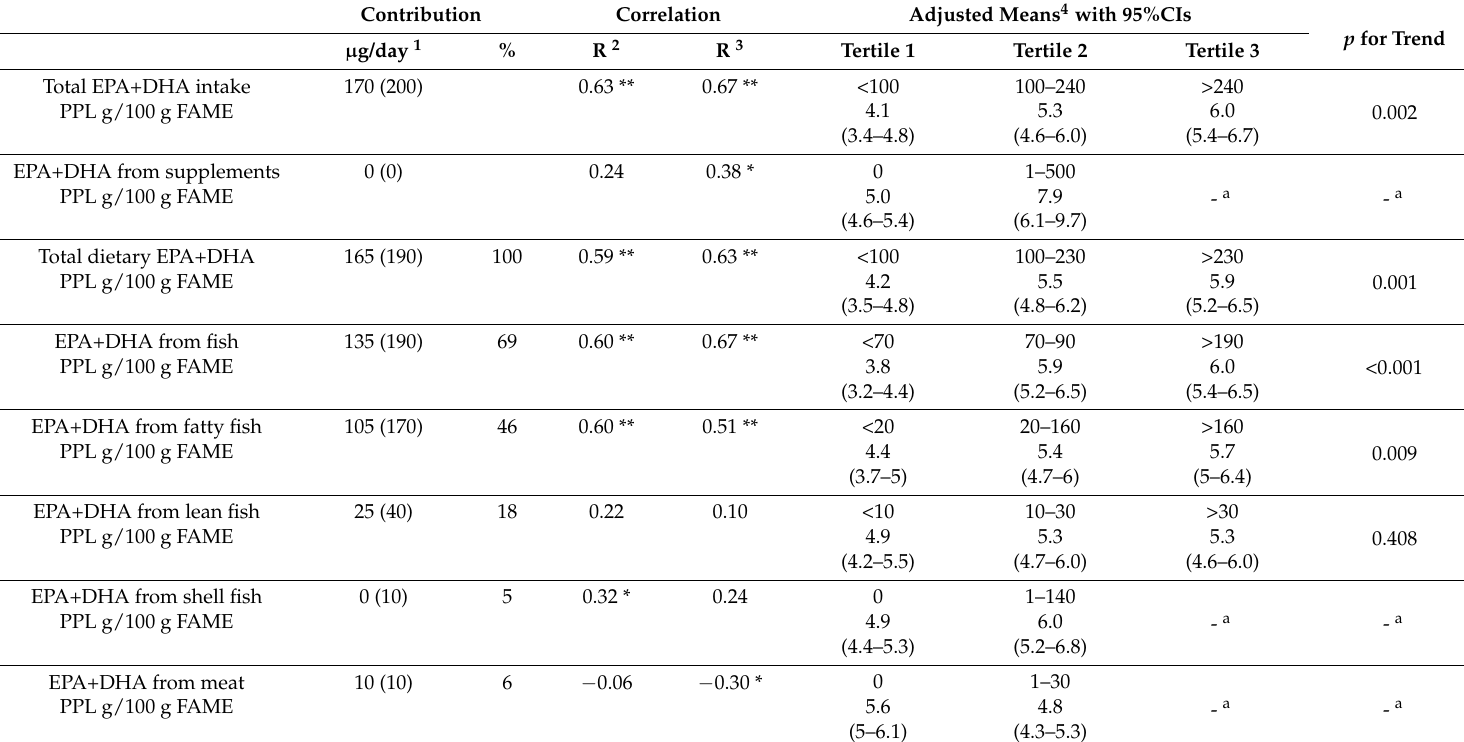
Table 4. Absolute (mg/day) and relative (%) contribution of dietary sources to total EPA and DHA intake, Spearman’s rank and partial correlation coefficients between EPA and DHA intake and plasma phospholipid EPA and DHA, and adjusted means with 95% confidence intervals for plasma phospholipid EPA and DHA (g/100 g FAME) according to tertiles of EPA and DHA intake (mg/day) among Dutch women with a pregnancy wish ( n =